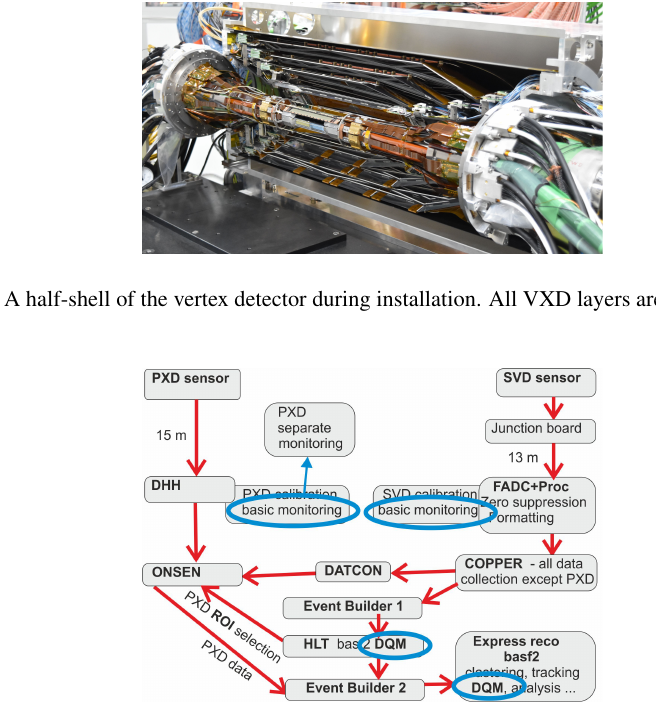
Figure 2. Data flow (red arrows) for the Belle II vertex subdetectors. The blue markings show data quality monitoring